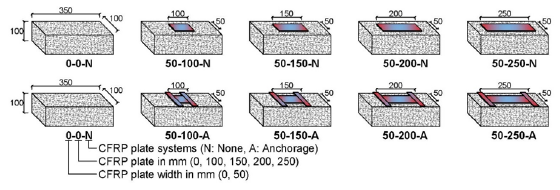
Fig. 1. Schematic of concrete beams externally bonded with CFRP plates